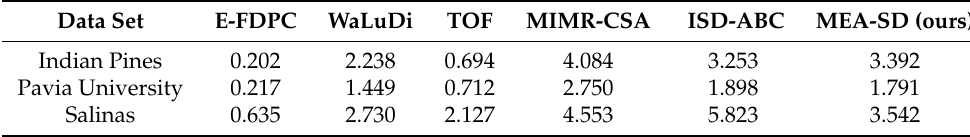
Table 8. Averaged computing time (s) of different band selection